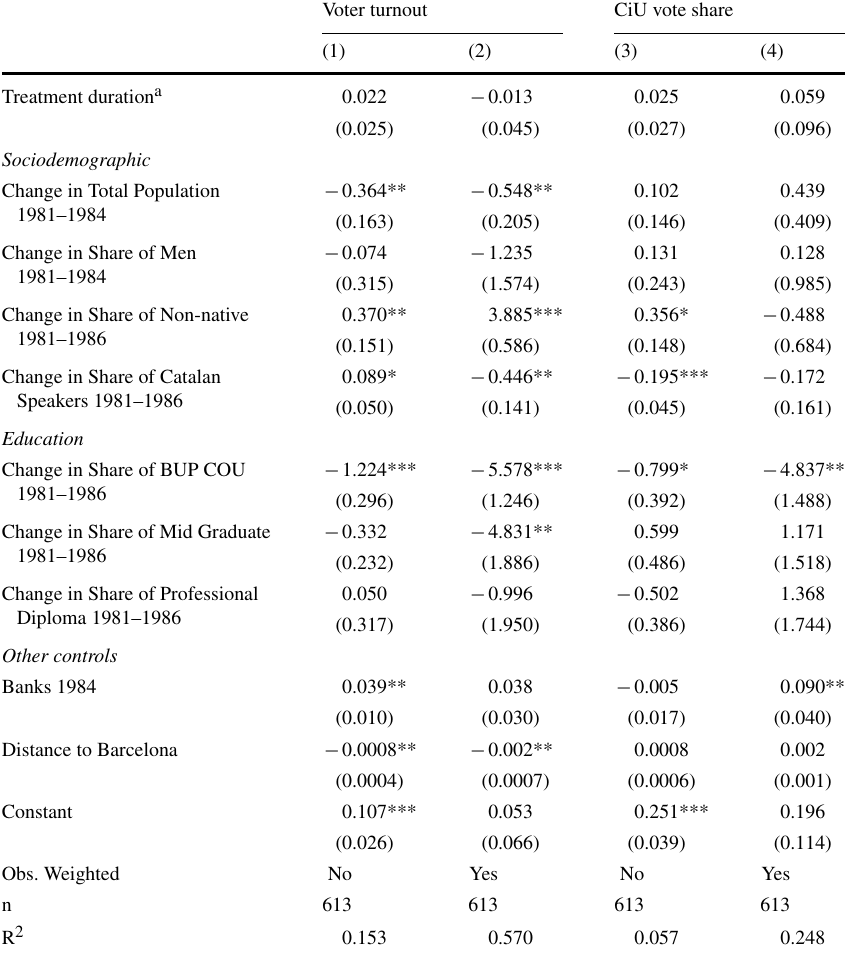
Table 4 Treatment duration